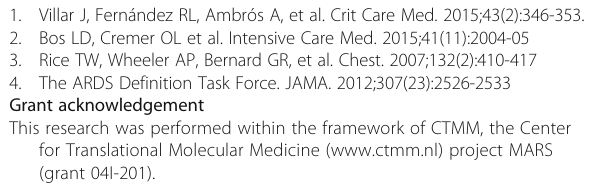
Table 6 (abstract A5). Distribution and Outcomes at baseline Group I Group II